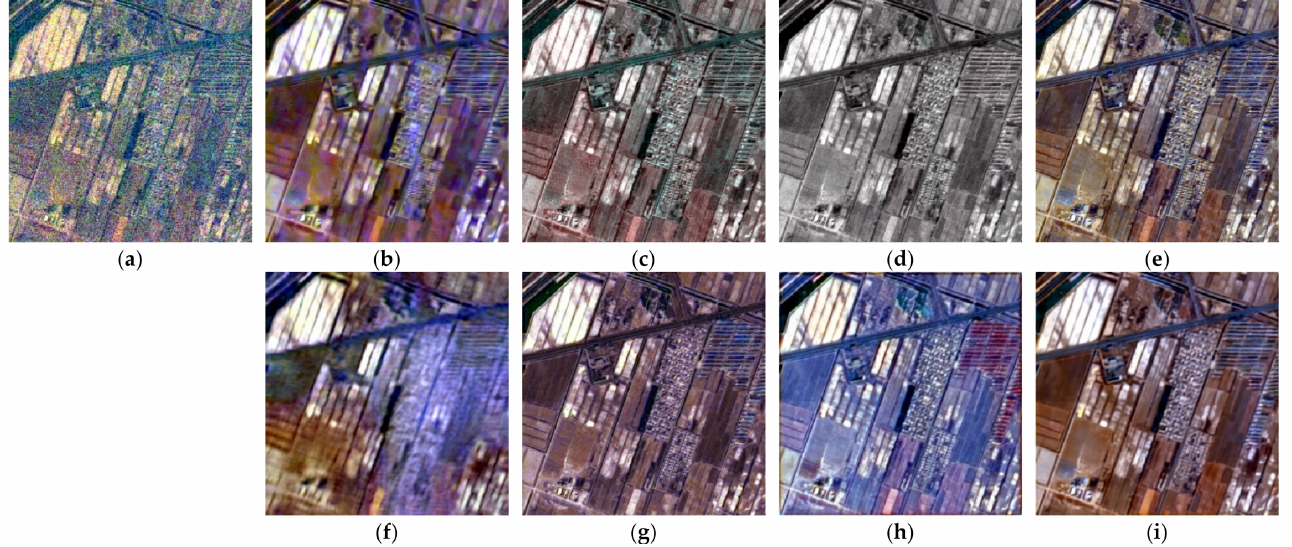
Figure 14. GF-14 hyperspectral image (VNIR) denoising results with false-color image (R: band 40, G: band 15, B: band 5): ( a ) real image; ( b ) BM4D; ( c ) LRMR; ( d ) HyRes; ( e ) L1HyMixDe; ( f ) DHP-2D; ( g ) SIP; ( h ) SURE-CNN; and ( i ) 3S-HSID.